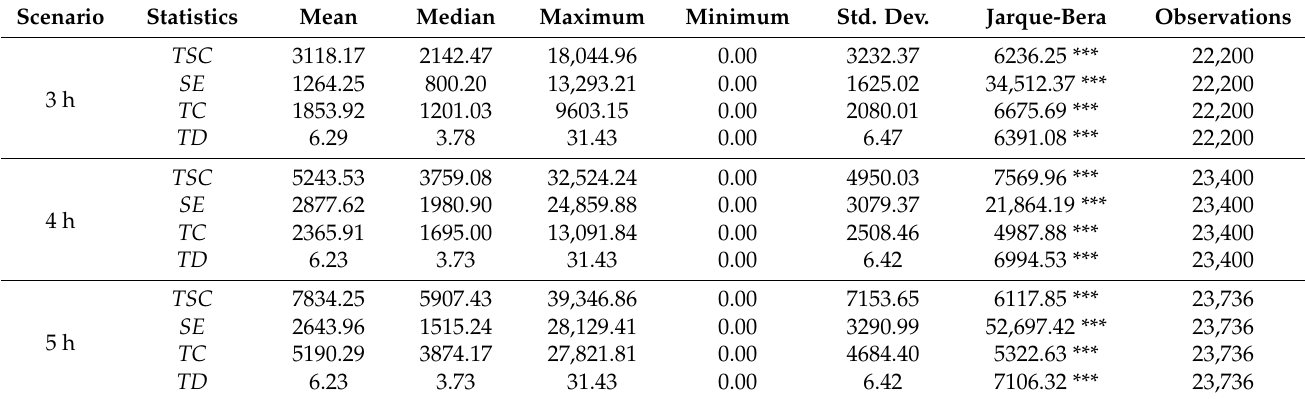
Table 1. Statistics of the Panel.